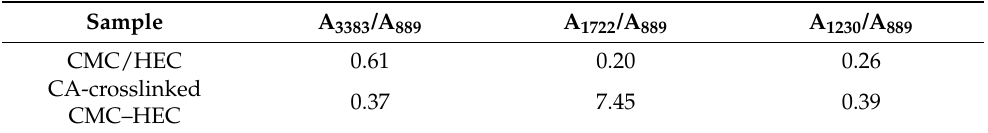
Table 1. Intensity ratio of the characteristic band associated with the crosslinking reaction of CMC– HEC via citric